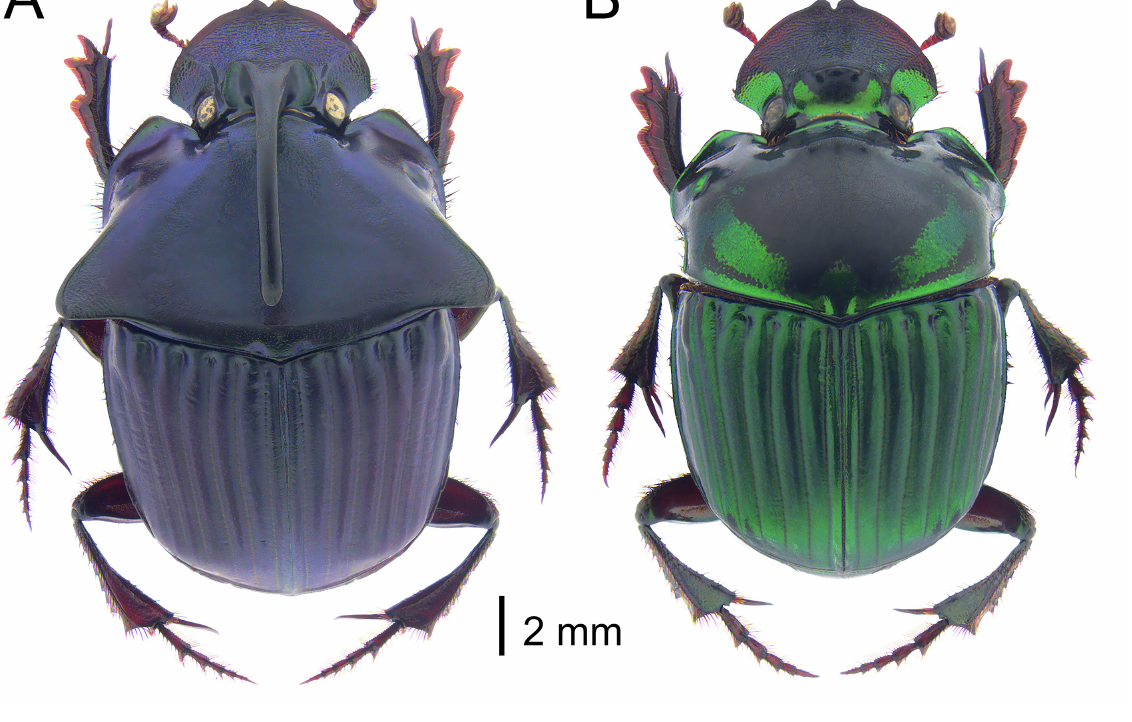
Fig. 3. Phanaeus chiapanecus sp. nov. A . Holotype, ♂, blue morph (typical; TAMU). B . ♀, green morph